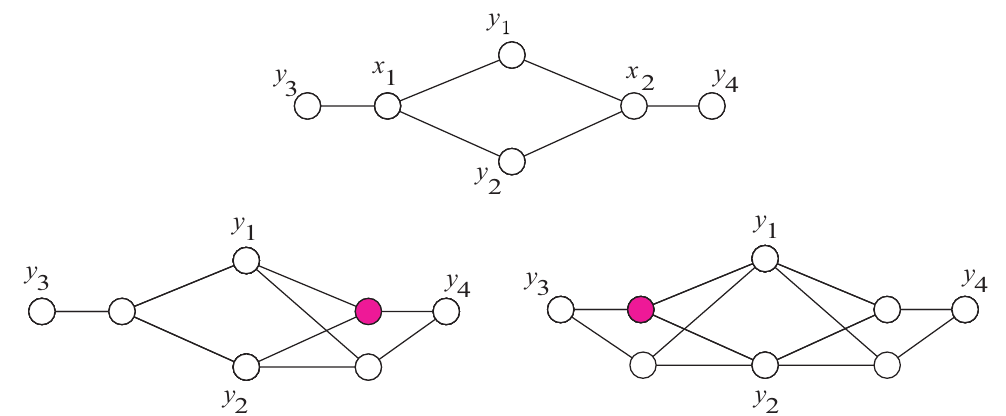
Figure 3: The basic bat graph and two expansions by twinning (each pink vertex has a newly created twin)